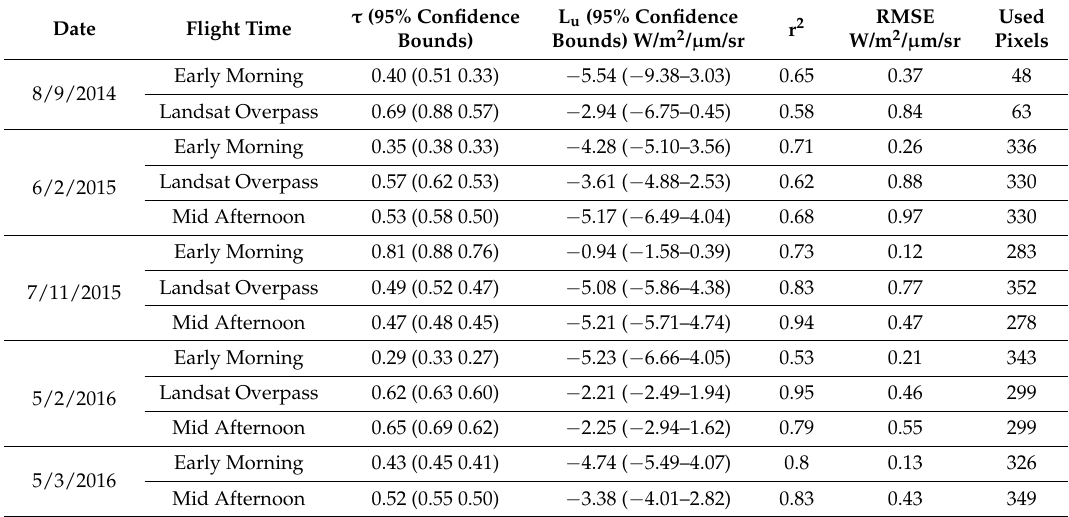
Figure 8. Example of ground temperature images georeferenced from locations shown in Figure 6 and others over a visual image using ArcGIS. The figure showcases thermal temperature images of two bare soil locations (top) and two tall canopies (vines) (bottom). Square grids indicate sUAS and ground pixels that can be extracted for atmospheric radiance calibration.